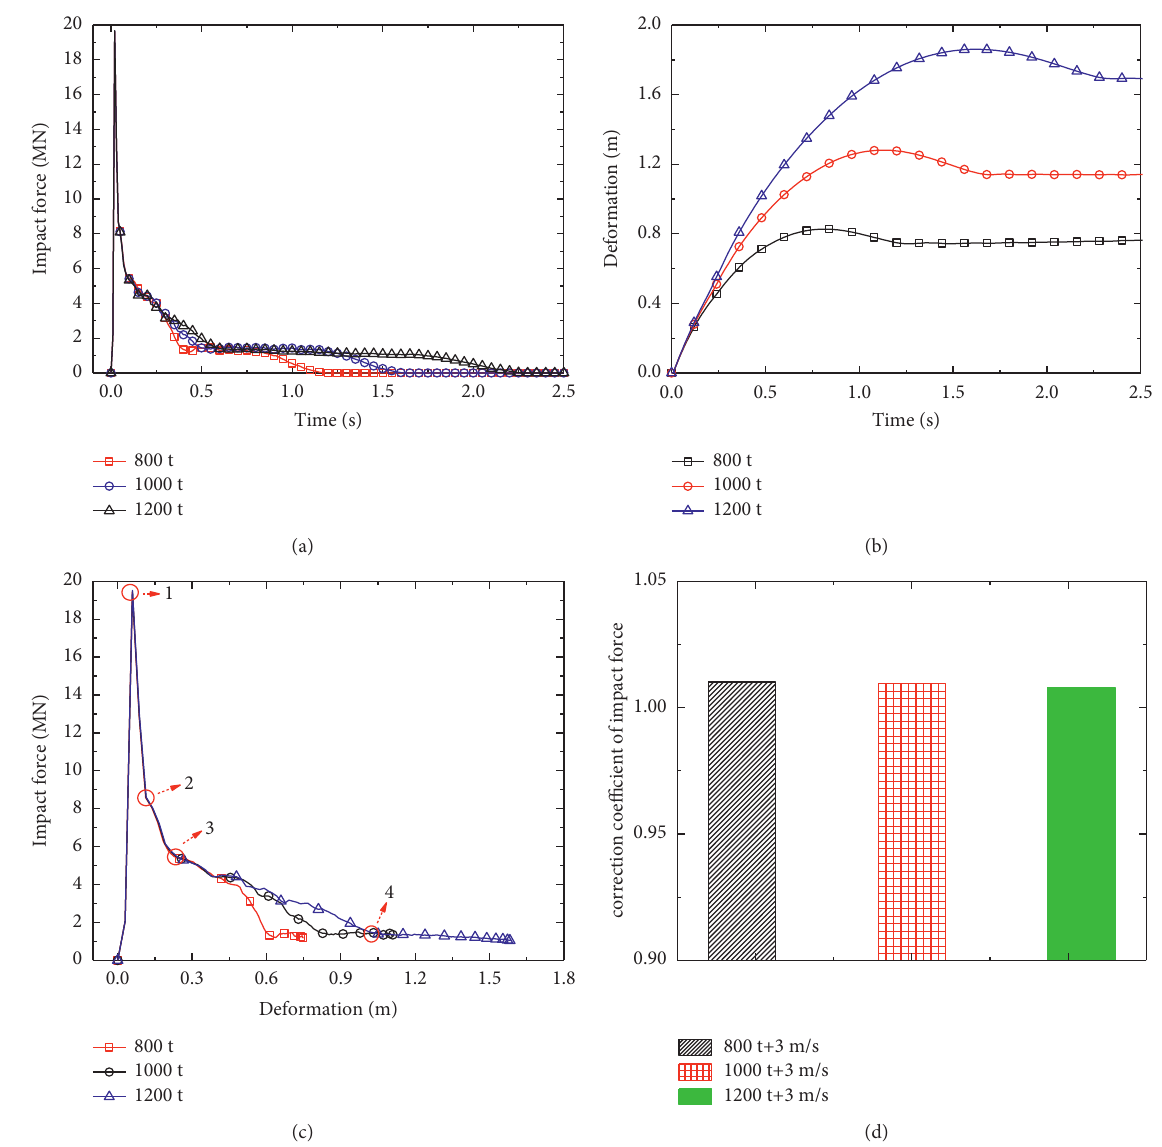
Figure 4: Simulation results under varying barge impact on the rigid wall. (a) Impact force under varying barge mass. (b) Bow deformation under varying barge mass. (c) NSS incurred under varying barge mass. (d) Correction coefficient of impact